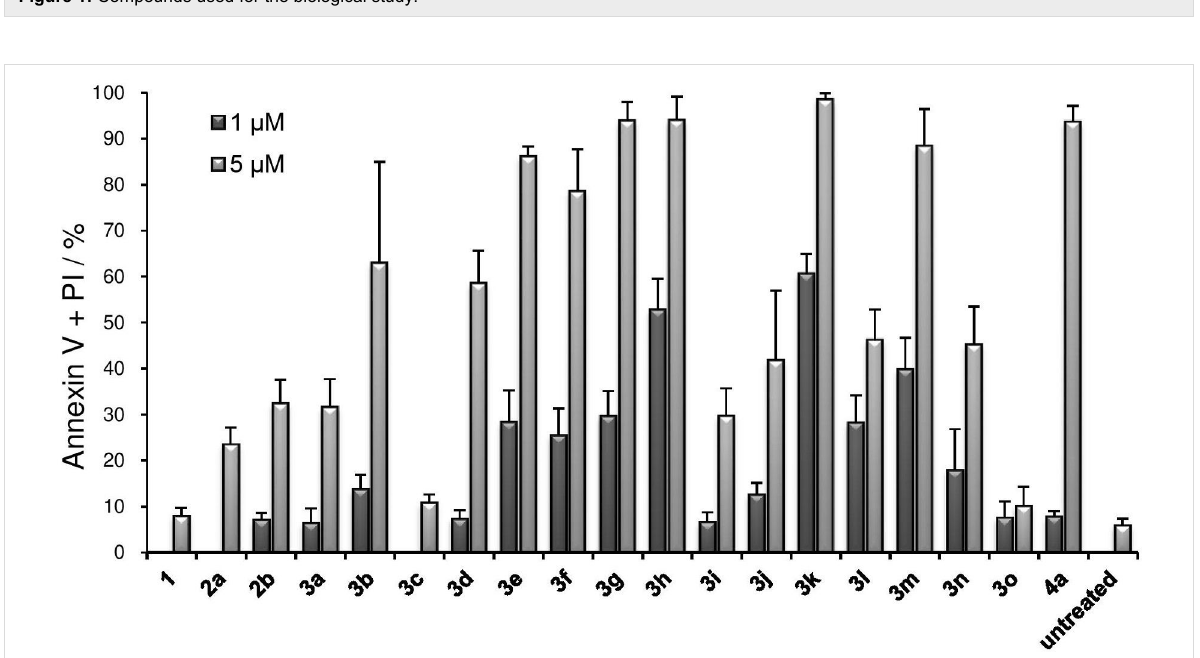
Figure 1: Compounds used for the biological study.